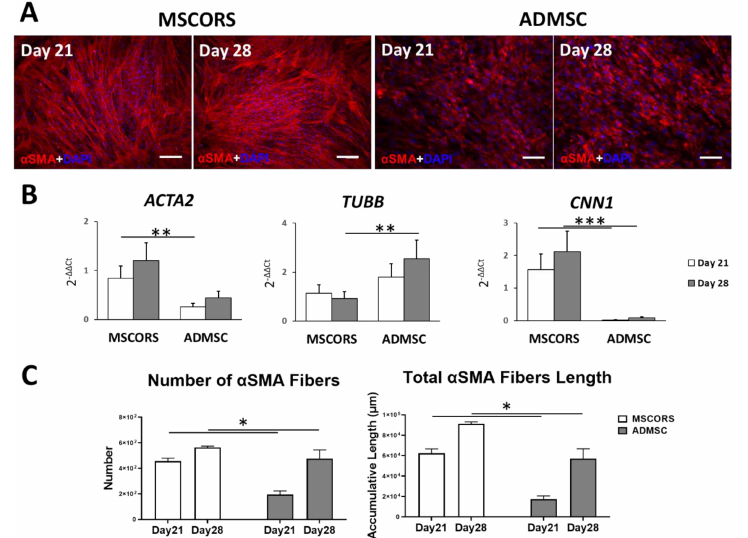
Figure 3. Smooth muscle differentiation of MSCORS and ADMSCs in vitro. ADMSCs and MSCORS underwent differentiation towards smooth muscle cell lineage for 21 and 28 days, evaluated via alpha smooth muscle actin ( α SMA) immunostaining, qRT-PCR of smooth muscle marker gene expression and quantitative analysis of α SMA fibers. ( A ) Immunostaining of α SMA on ADMSC and MSCORS during smooth muscle cell differentiation (scale bar: 200 µ m; magnification 10 × ). ( B ) Gene expressions of smooth muscle markers actin alpha 2 ( ACTA2) , Tubulin Beta Chain (TUBB) , Calponin 1 (CNN1) in differentiated ADMSC and MSCORS. Gene expressions were normalized to the housekeeping gene HTRP-1 and calculated using 2 - ∆∆ Ct method against undifferentiated ADMSCs and MSCORS. ( C ) Quantitative analysis of α SMA fibers, in terms of number and length obtained using ImageJ software. Results are shown as mean ± SD (* p < 0.05, ** p < 0.01, *** p <